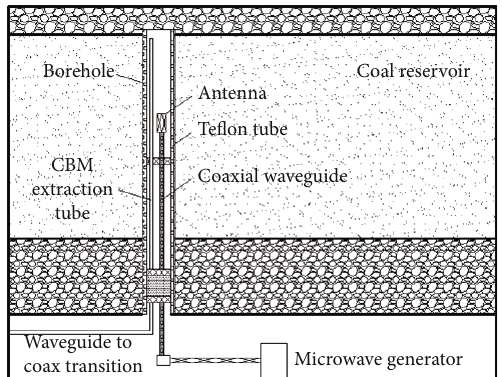
Figure 16: The conceptual design of the microwave heating stimulation technique